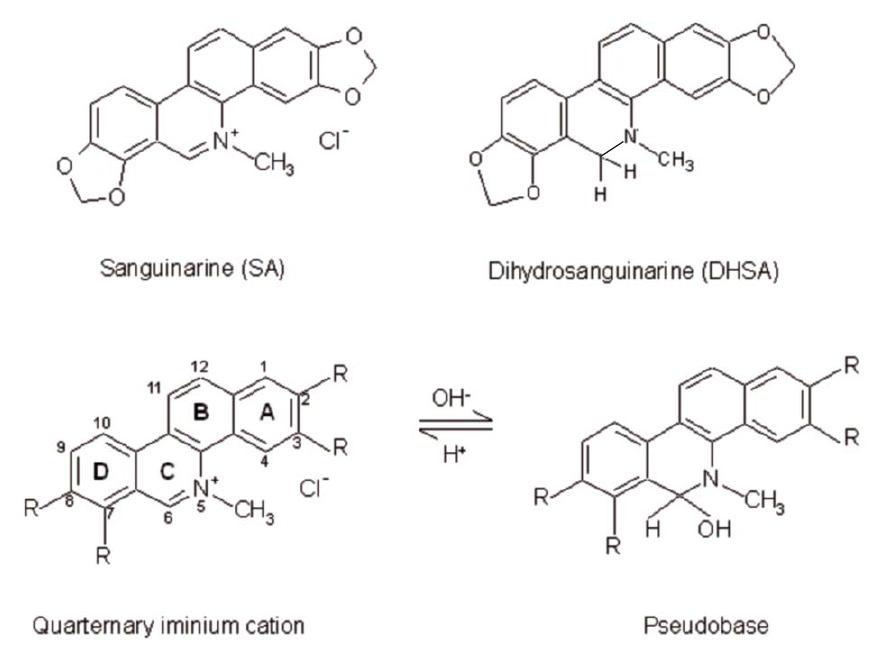
Figure 1. The structural formulas of alkaloids sanguinarine (SA) and dihydrosanguinarine (DHSA) and the equilibrium between their charged and uncharged